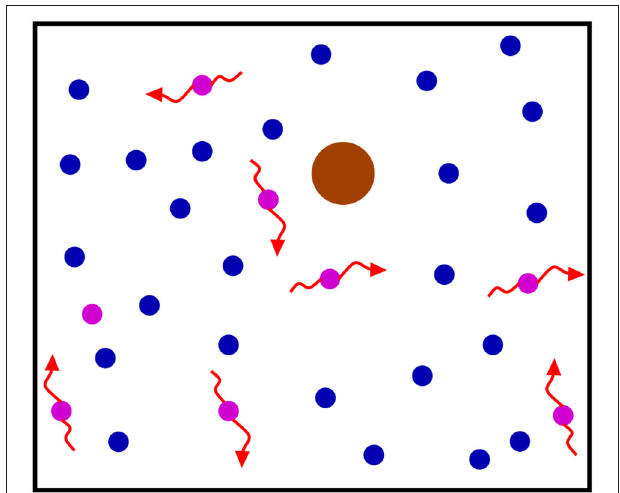
FIGURE 8 | Cartoon of three levels: slow probe, faster non-equilibrium medium and even faster thermal bath. The probe motion perturbs its environment. The response of the medium is needed to derive the fluctuating dynamics of the